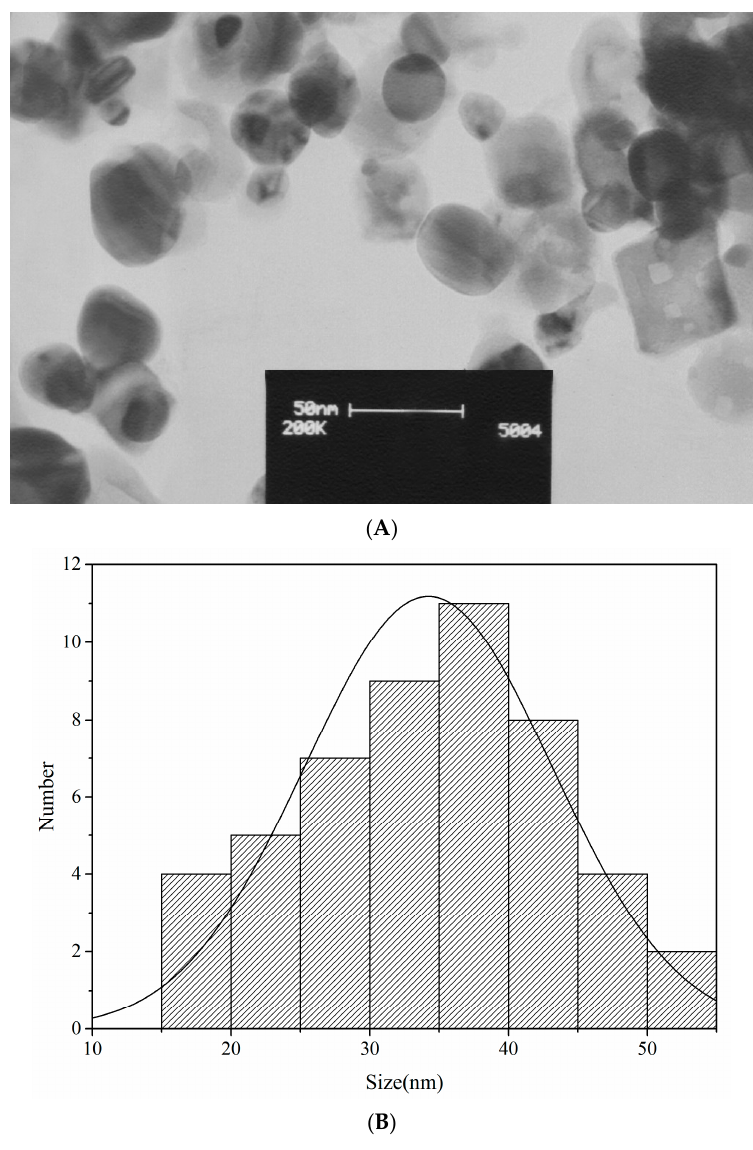
Figure 3. ( A ) The TEM image and ( B ) the particles size distribution of the AgNPs greenly synthesized by the A. tribuloides root extract acquired by using the TEM image (particles number = 50). Each bar shows the nanoparticles number with a certain size